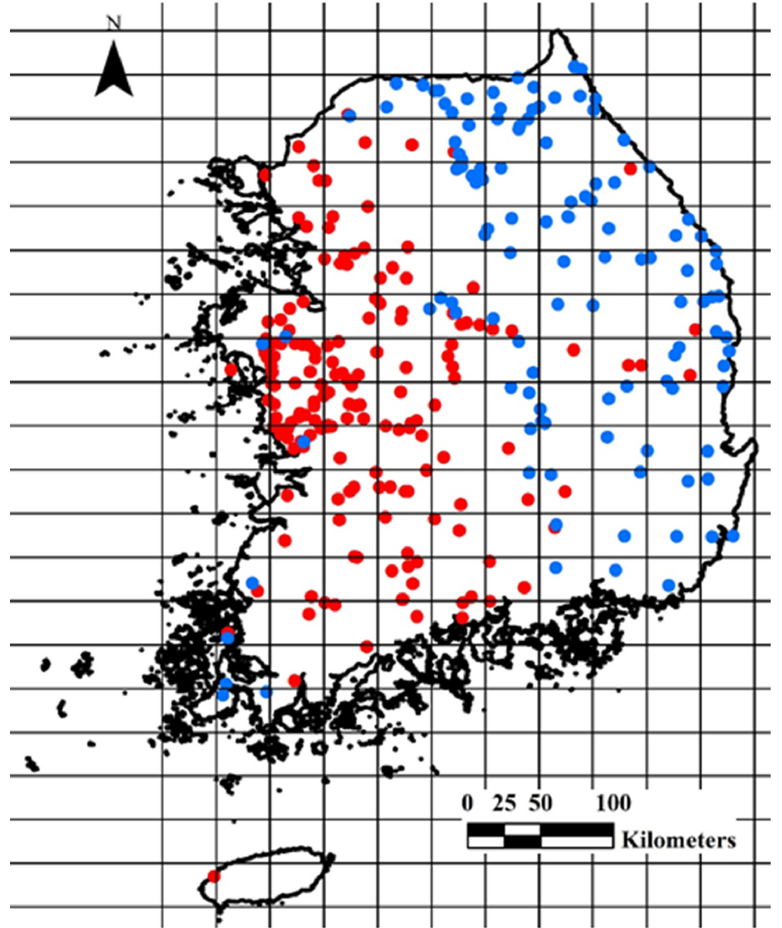
Figure 1. Imaginary grids (30 km × 30 km) and observed points for the presence of Ricania shantungensis in Korea ( ● , Presence; ● , Absence).